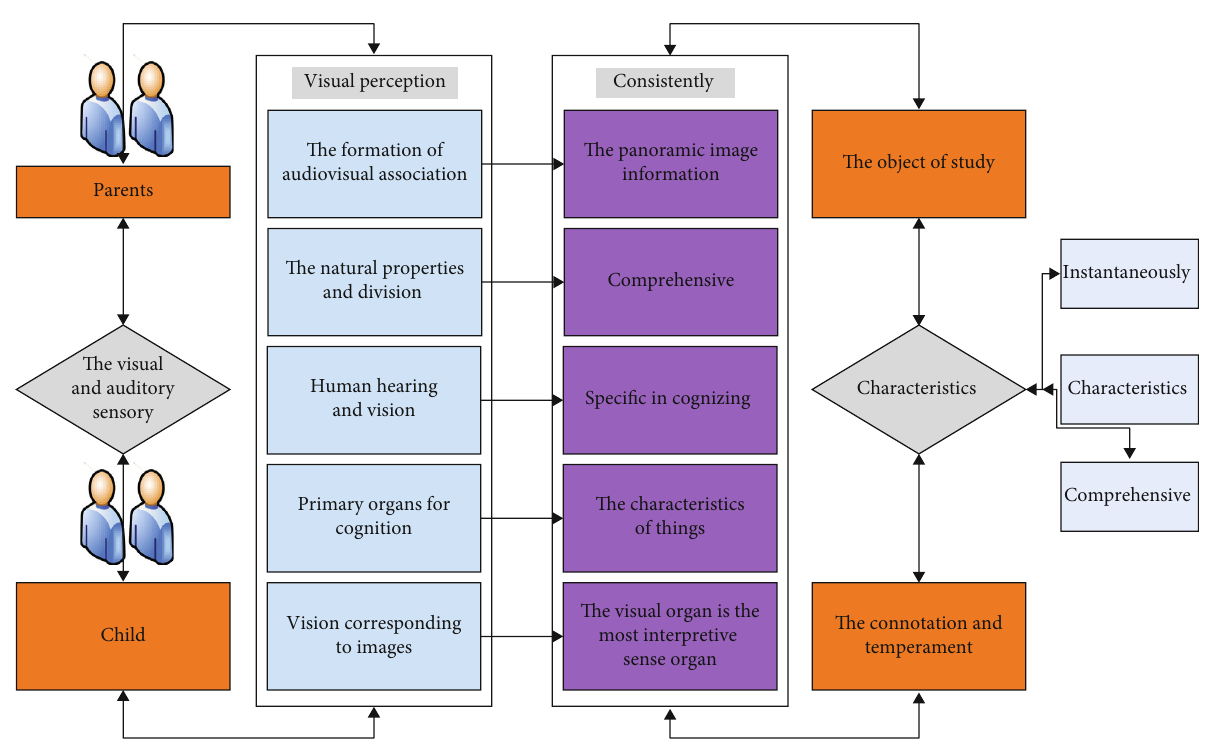
Figure 3: Design elements of audiovisual associative experience